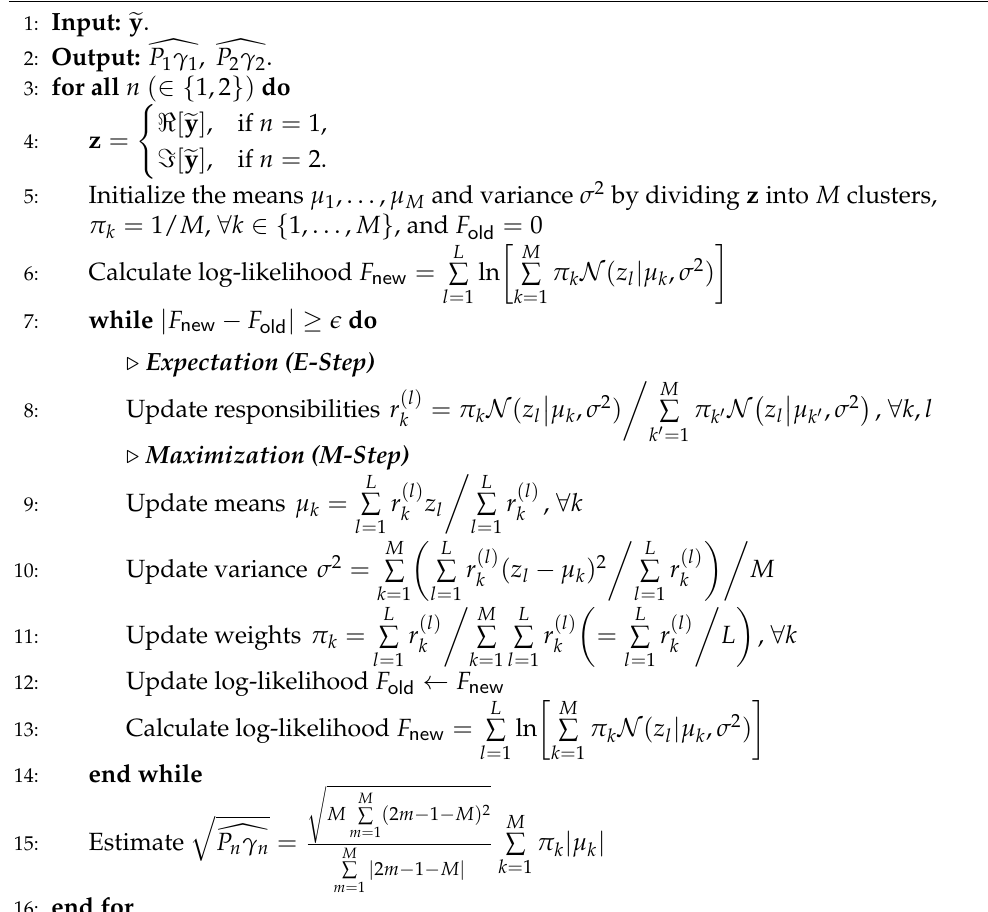
Algorithm 1 Blind energy estimation (BEE)